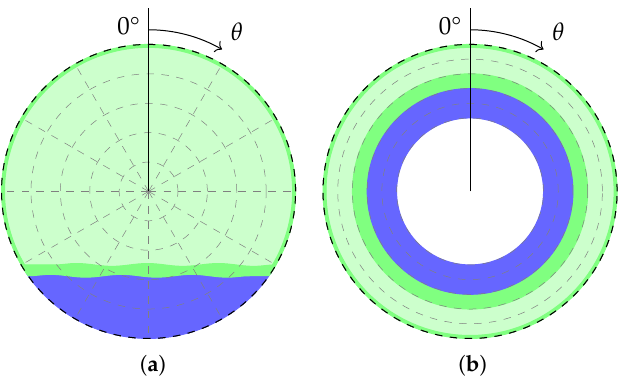
Figure 4. Inflow distortion and PCM segmentation: ( a ) Asymmetric BLI. ( b ) Full annular BLI. Pale green denotes the free stream; blue represents areas of low momentum